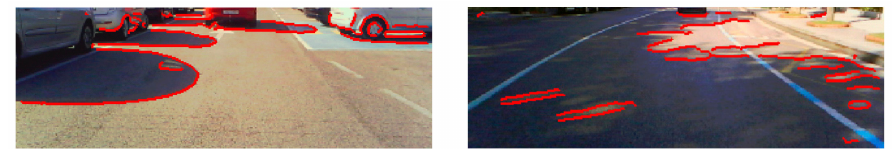
Figure 6. Shadow edge detection obtained by the constraint which relates the green–red and the green–blue proportions of Property 3, i.e., Equation (22).